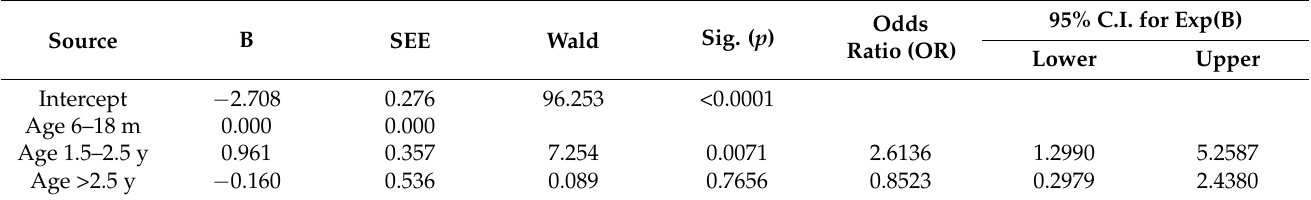
Table 10. Results of the regression analysis (predicted variable: wild boar age; explanatory variable: Brucella seroprevalence).